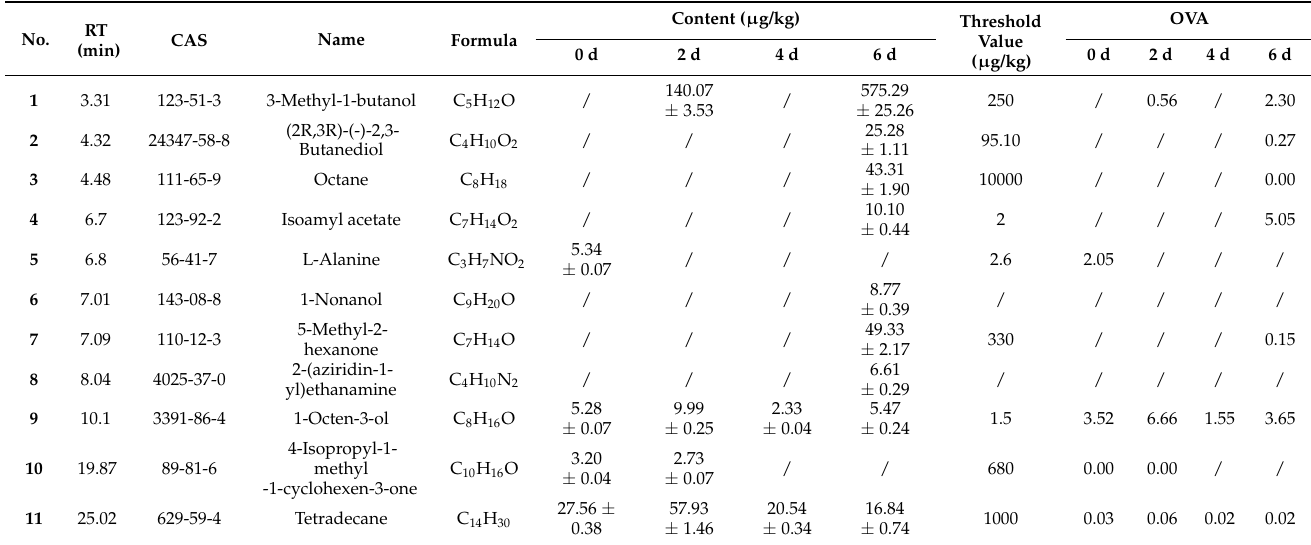
Table 2. Changes in the volatile flavor compounds in the marinated